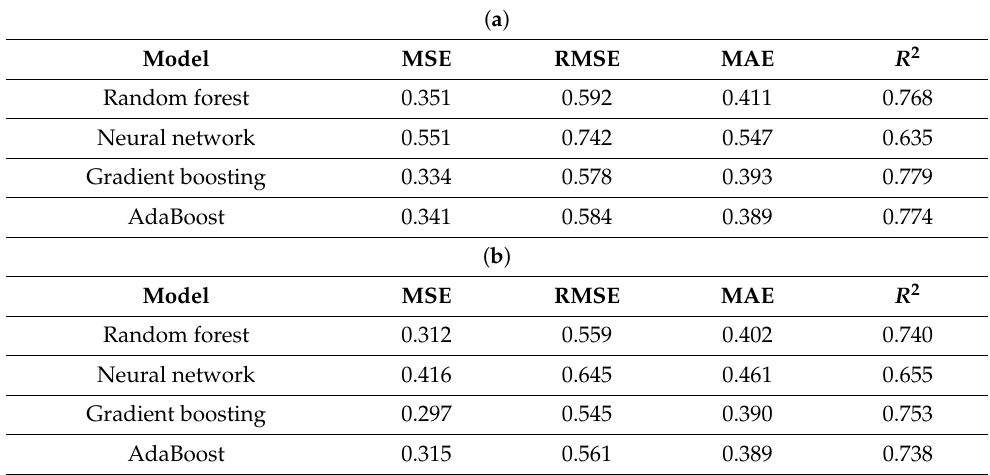
Table 8. ( a ) Result of ML models with training original data. ( b ) Result of ML models testing original data. ( a ) Model MSE RMSE MAE R 2 Random forest 0.351 0.592 0.411 0.768 Neural network